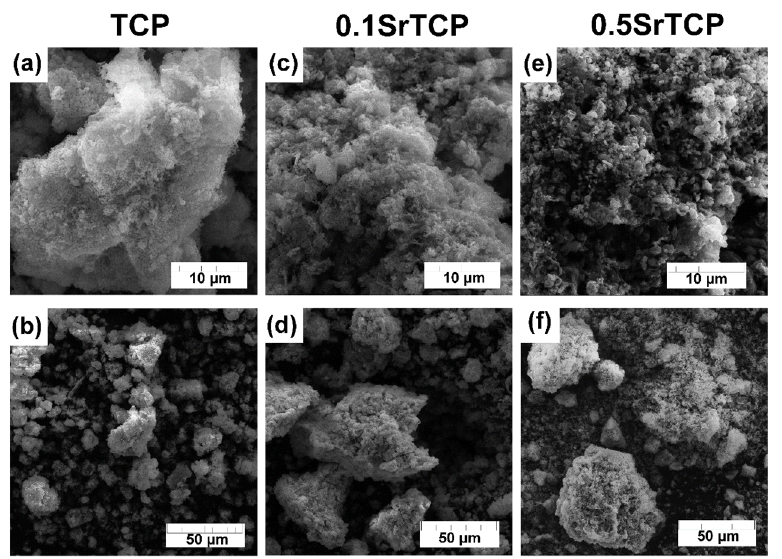
Figure 2. SEM images of TCP ( a , b ), 0.1SrTCP ( c , d ), and 0.5SrTCP ( e , f ) powders calcinated at 900 °C at 10 and 50 μ m resolutions.